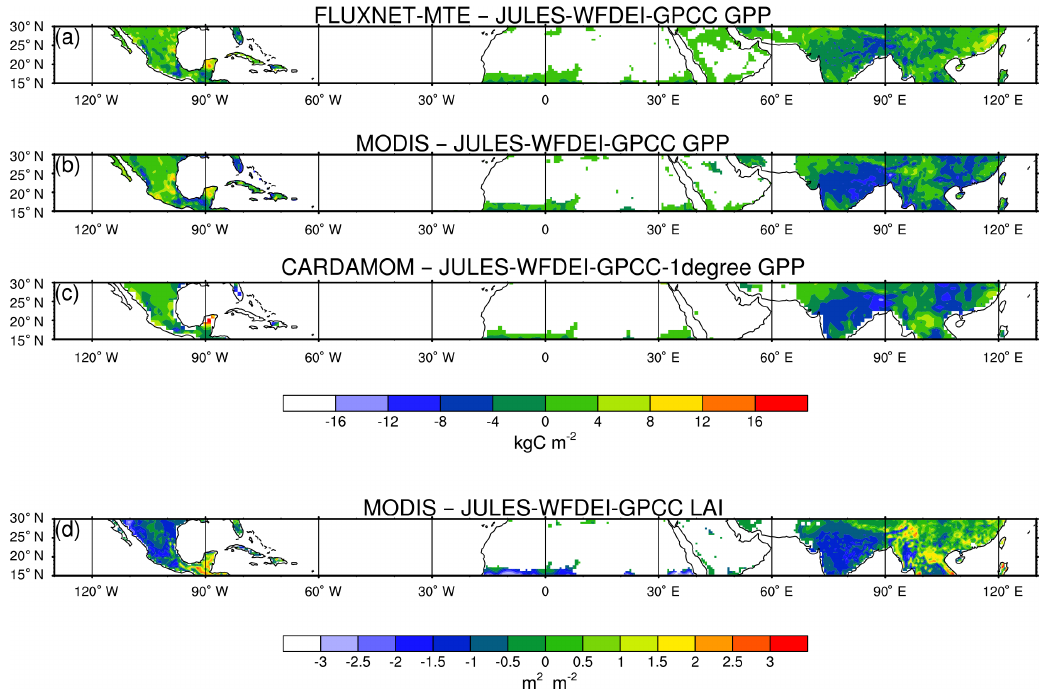
Figure 8. Difference in total annual GPP between JULES-WFDEI-GPCC and the observation-based (FLUXNET-MTE and MODIS) and CARDAMOM estimates of GPP and in monthly mean LAI between JULES-WFDEI-GPCC and MODIS at latitudes 15–30 ◦ N for the 2001–2010 period. Panel (a) shows the difference in GPP between FLUXNET-MTE and JULES, (b) between MODIS and JULES and (c) between CARDAMOM and JULES. Panel (d) shows the difference in LAI between MODIS and JULES. A positive change in GPP means the observation-based estimates (FLUXNET-MTE and MODIS) or CARDAMOM estimate are higher than the model and in LAI means MODIS LAI is higher than